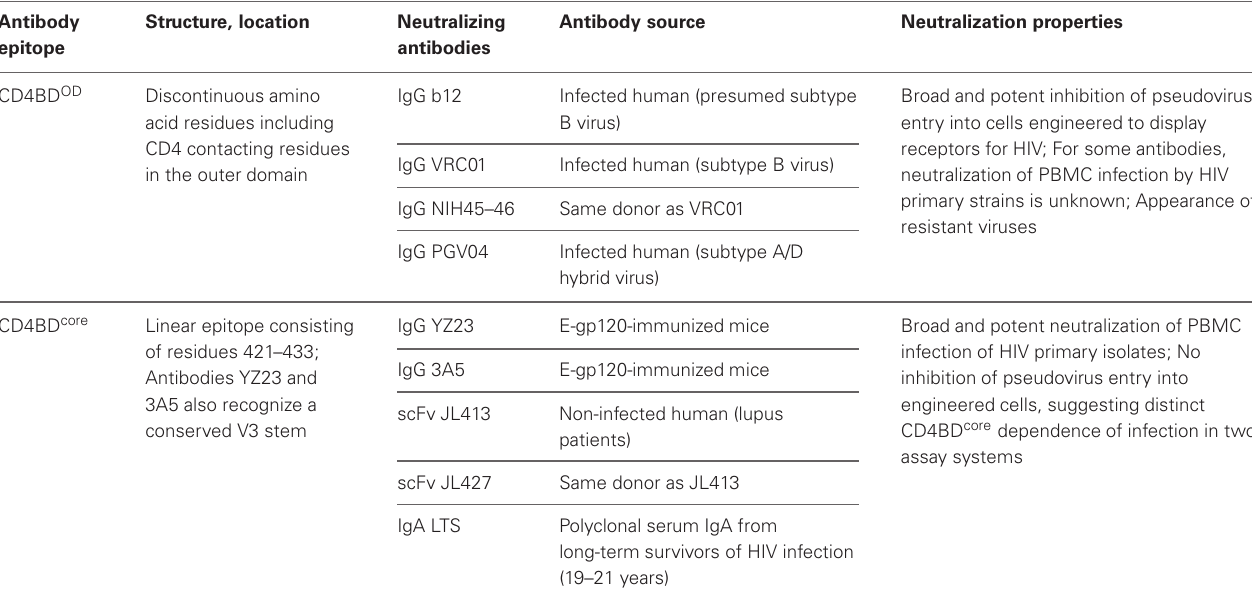
Table 1 | gp120 CD4BD neutralizing